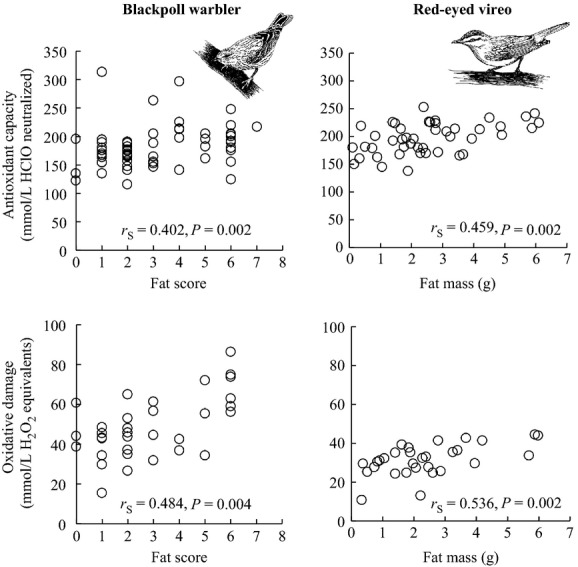
Fat stores were correlated with both antioxidant capacity and oxidative damage among Blackpoll Warblers (left) and Red-eyed Vireos (right) in autumn on Block Island, USA. Although fat score was measured in Red-eyed Vireos, it was less strongly correlated with oxidative measures than fat mass.